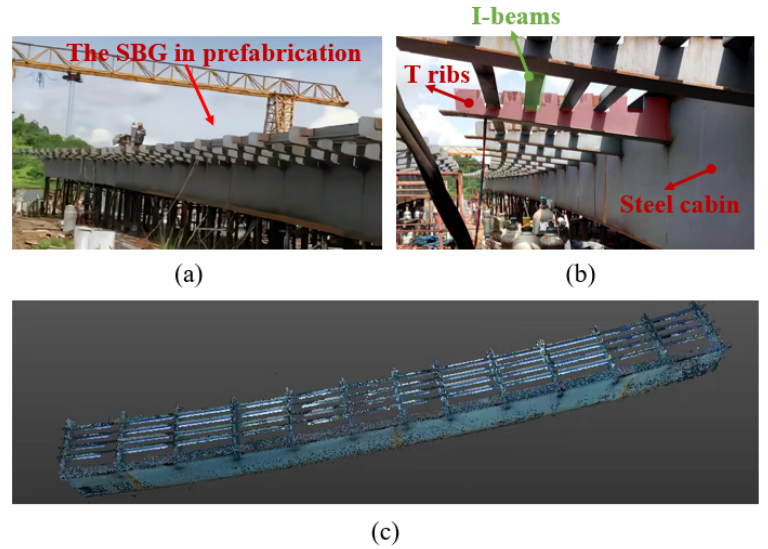
Figure 11. The SBG overview: ( a , b ) the SBG in prefabrication; ( c ) laser-scanned data for prefabricated SBG components. SBG